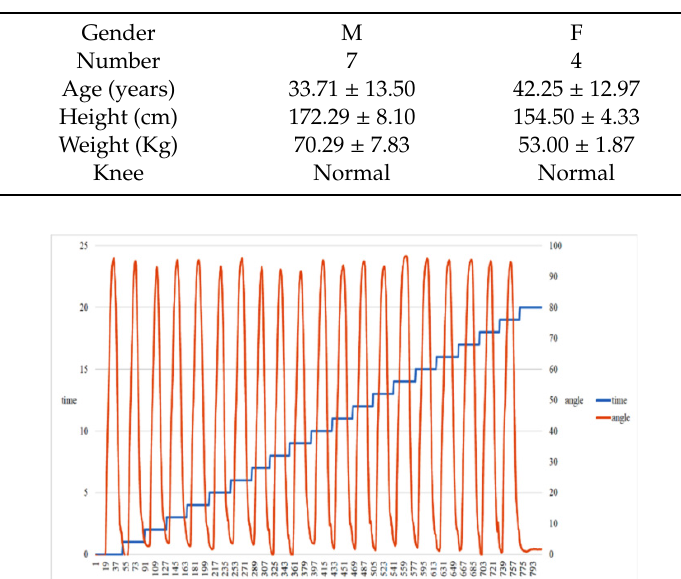
Figure 13. Swing angles and number of swings from one of the participants. Note that the horizontal axis represents the index of sequentially collected sensor signals.